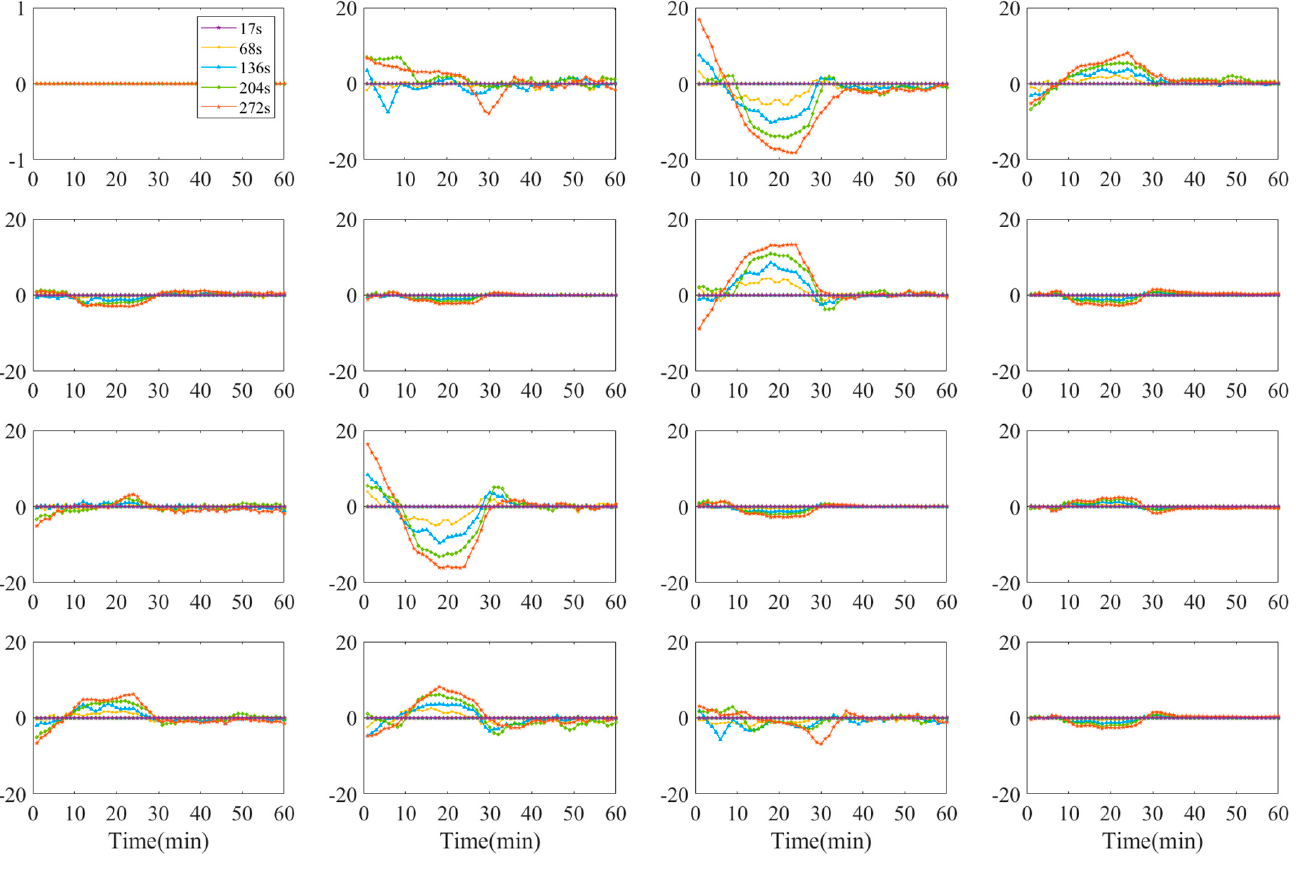
Figure 5. Relationship between the error of true value and test value and the rate of change of true value itself at different times of single measurement: 17 s (the purple line), 68 s (the yellow line), 136 s (the blue line), 204 s (the green line) and 272 s (the red line). The horizontal axis represents the time after application of 10% glycerin to the double-layer tissue and the vertical axis represents the value of the error value between the true and test values of the Mueller matrix element divided by the rate of change of the true value itself at different measurement times.